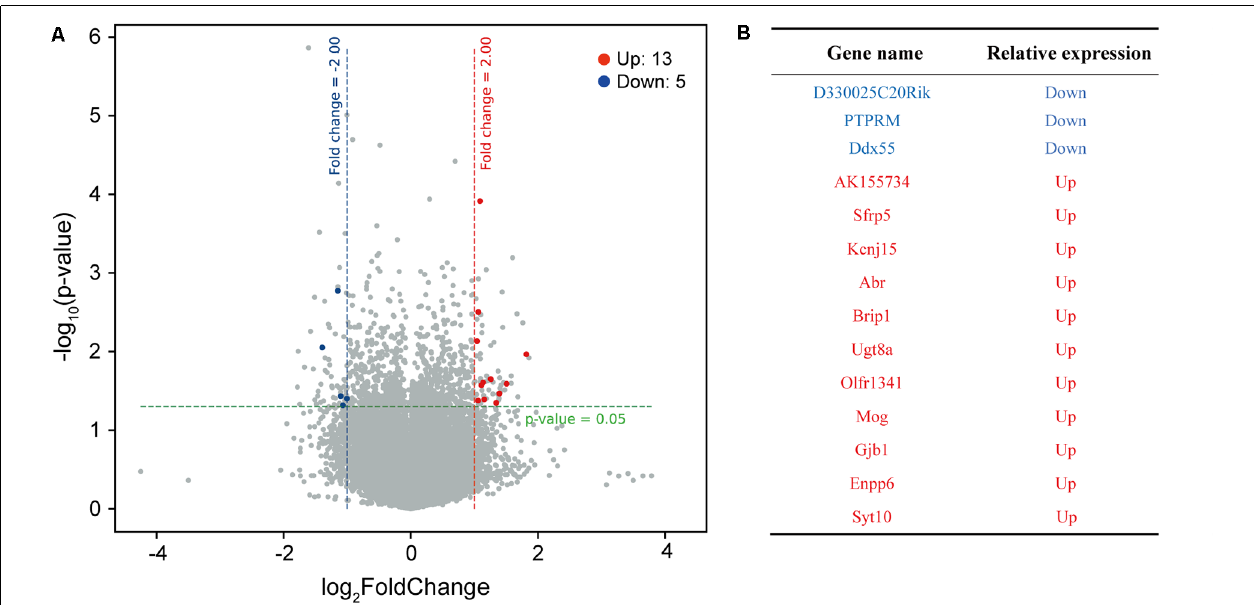
FIGURE 3 | The DEGs of neuron cultured with or without Zn 2+ analysis by microarray hybridization. (A) The volcano map of differential expressed gene. Take neurons cultured with 0 µ M as a control group, analyze differentially expressed genes of neurons cultured with 50 µ M. The red dots on the map represent significantly upregulated expressed genes, blue dots represent significantly downregulated expressed genes, and black dots represent genes whose expression levels have not changed significantly. The filter condition for differentially expressed genes was a fold change ≥ 2.0 and a P value ≤ 0.05. (B) The table shows the names of differentially expressed genes that encode proteins. Red is upregulated, and blue is